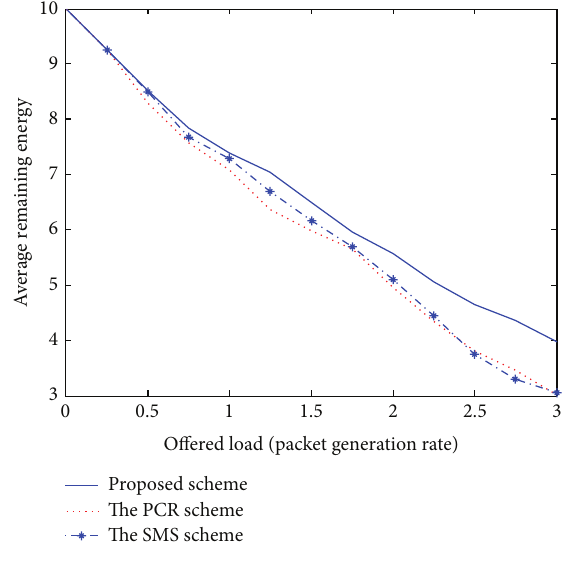
Figure 1: Average remaining energy. Figure 2: Network throughput.